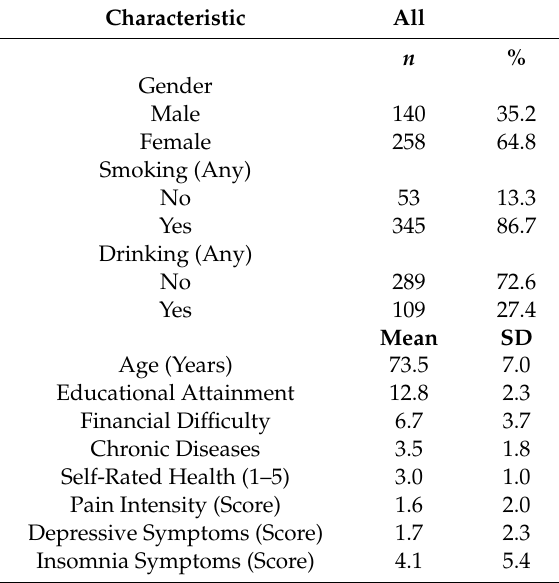
Table 1. Descriptive